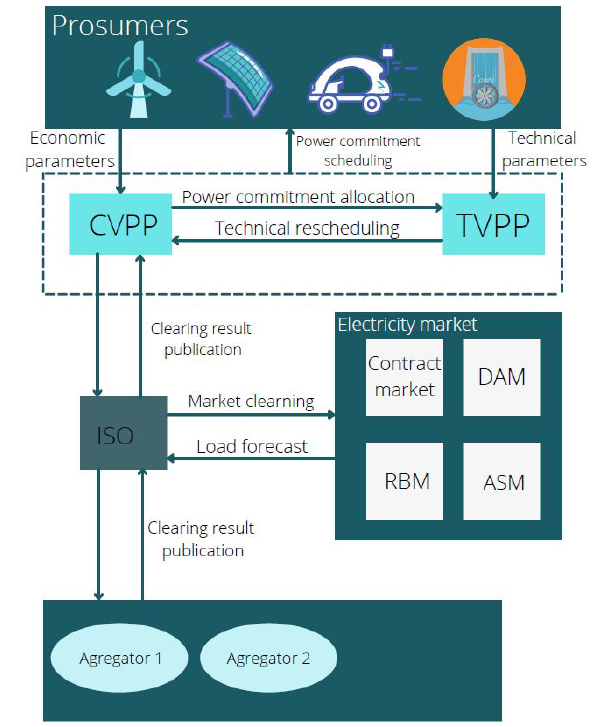
Figure 3. Framework of